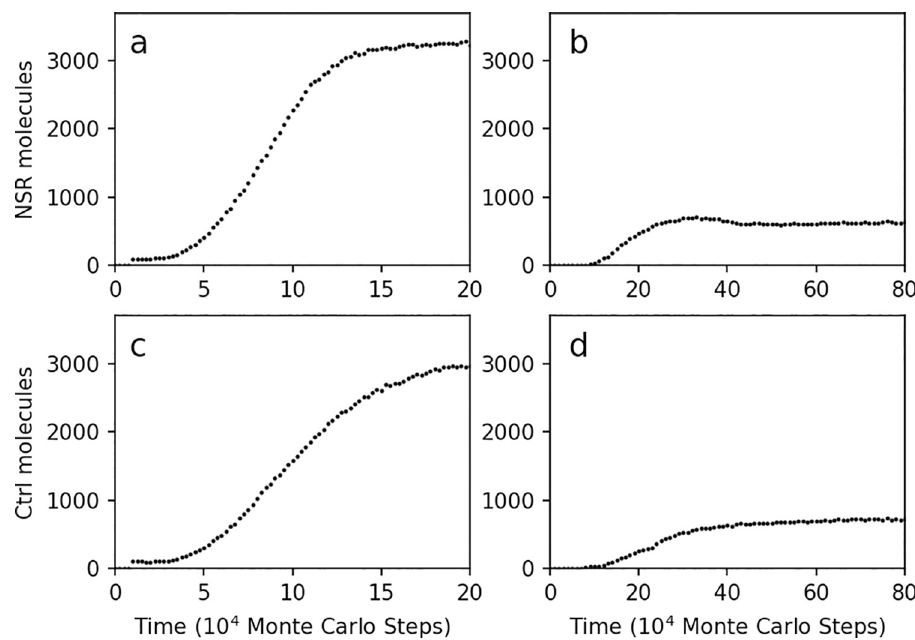
Fig 4. The parameter setting resulting from the machine-learning turned out to favor both the spread of NSR and that of non-functional RNA species. In reference of the case shown in Fig 2A with learning rate of 0.2 (the red line), the parameter set at the 200th round of the machine-learning is adopted: PNF = 3.04 × 10 − 4 , PNFR = 5.51 × 10 − 3 , PND = 0.0194, PRL = 7.25 × 10 − 8 , PBB = 6.24 × 10 − 8 , PAT = 0.0763, PFP = 3.51 × 10 − 4 , PMV = 4.36 × 10 − 5 . At step 1 × 10 4 , ( a ) one hundred NSR molecules are inoculated; ( b ) one NSR molecule is inoculated; ( c ) one hundred control (Ctrl) molecules, which have no enzymatic activity, are inoculated; ( d ) one control molecule is inoculated.